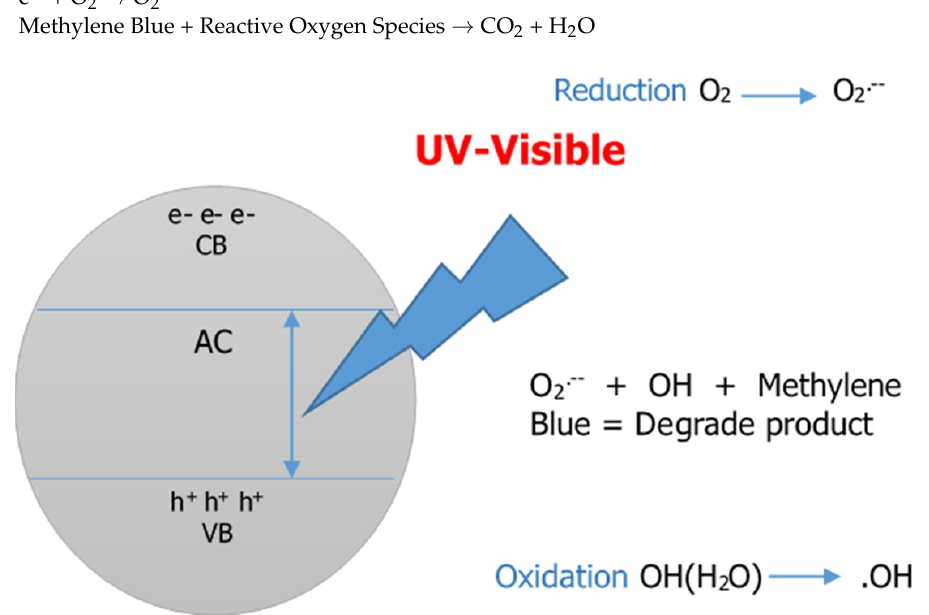
Figure 4. Schematic representation of photocatalysis and its impacts on the degradation of methylene blue [49].